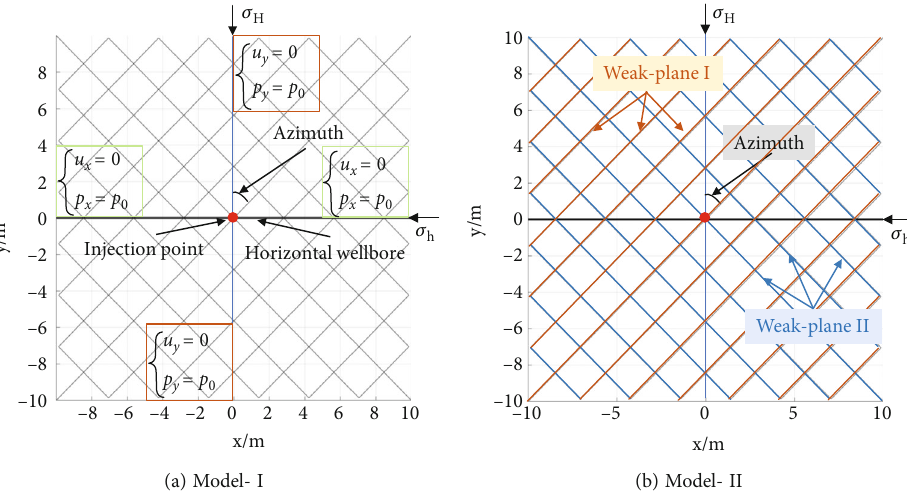
Figure 5: Two ideal weak plane distribution models based on real shale